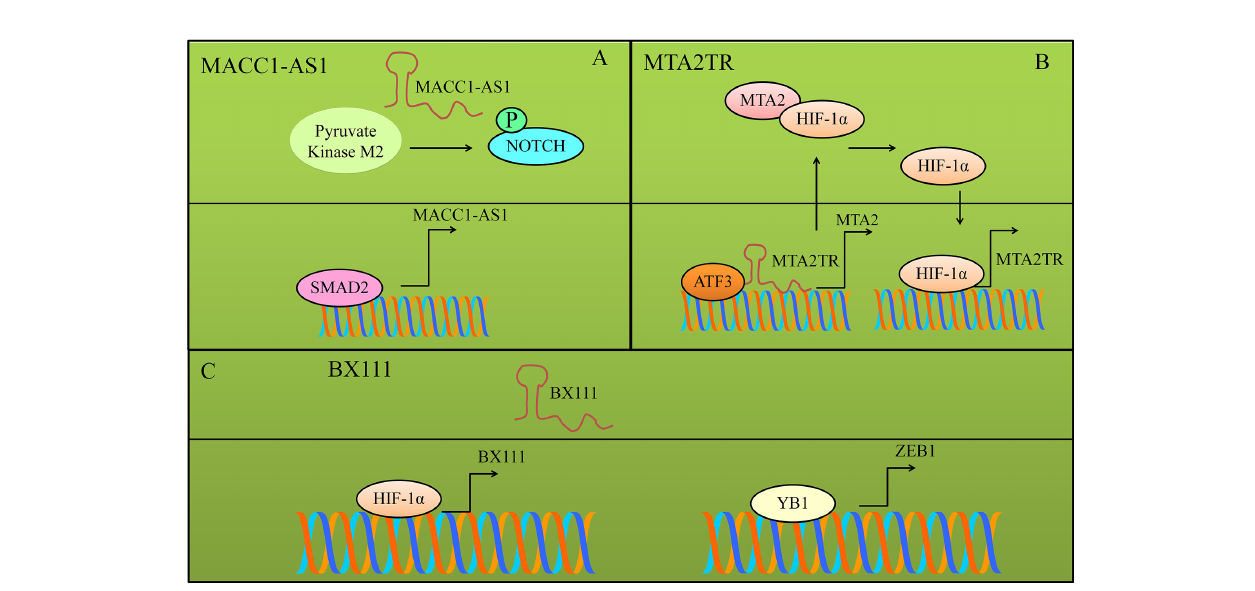
FIGURE 4 | Different proteins transcriptionally upregulated the expression of various lncRNAs. (A) SMAD2 transcriptionally upregulated MACC1-AS1. MACC1-AS1 stabilized and promoted pyruvate kinase M2-driven phosphorylation of NOTCH1. Oncogenic NOTCH1 pathway was activated by MACC1-AS1 through pyruvate kinase M2. (B) MTA2TR and ATF3 assembled in the nucleus and stimulated the expression of MTA2. MTA2 stabilized HIF protein and consequently HIF transcriptionally activated MTA2TR. (C) BX111 was transcriptionally stimulated by HIF-1 a . Furthermore, BX111 facilitated the binding of YB1 to promoter region of